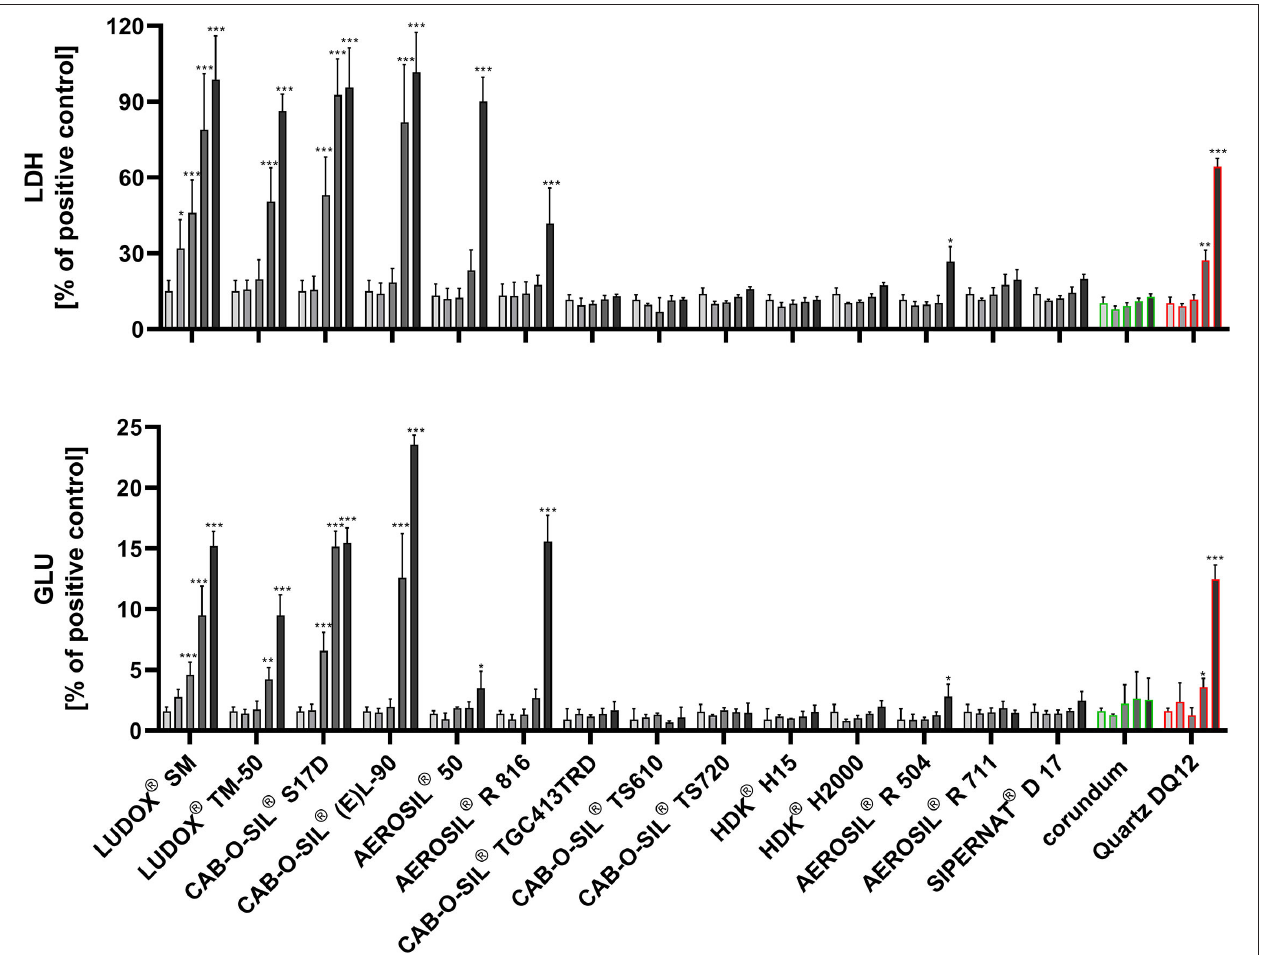
FIGURE 3 | Comparison of the in vitro response of NR8383 alveolar macrophages to untreated and surface-treated SAS. All SASs were dispersed with Protocol 1 (columns from left to right: 0, 11.25, 22.5, 45, and 90 µ g/ml). (Upper panel) lactate dehydrogenase activity (LDH); (lower panel) glucuronidase activity (GLU); LDH and GLU values are shown relative to the triton X-100 positive control. Untreated SAS: LUDOX ® SM, LUDOX ® TM 50, CAB-O-SIL ® S17D, CAB-O-SIL ® (E)L-90, AEROSIL ® 50. Surface-treated SAS: AEROSIL ® R 816, CAB-O-SIL ® TGC413TRD, CAB-O-SIL ® TS610, CAB-O-SIL ® TS720, HDK ® H15, HDK ® H2000, AEROSIL ® R 504, AEROSIL ® R 711, SIPERNAT ® D 17. Corundum and quartz DQ12 particles (0, 22.5, 45, 90, and 180 µ g/ml) were used as negative and positive controls. Values significantly different from cell control are marked by asterisks (* P ≤ 0.05, ** P ≤ 0.01, *** P ≤